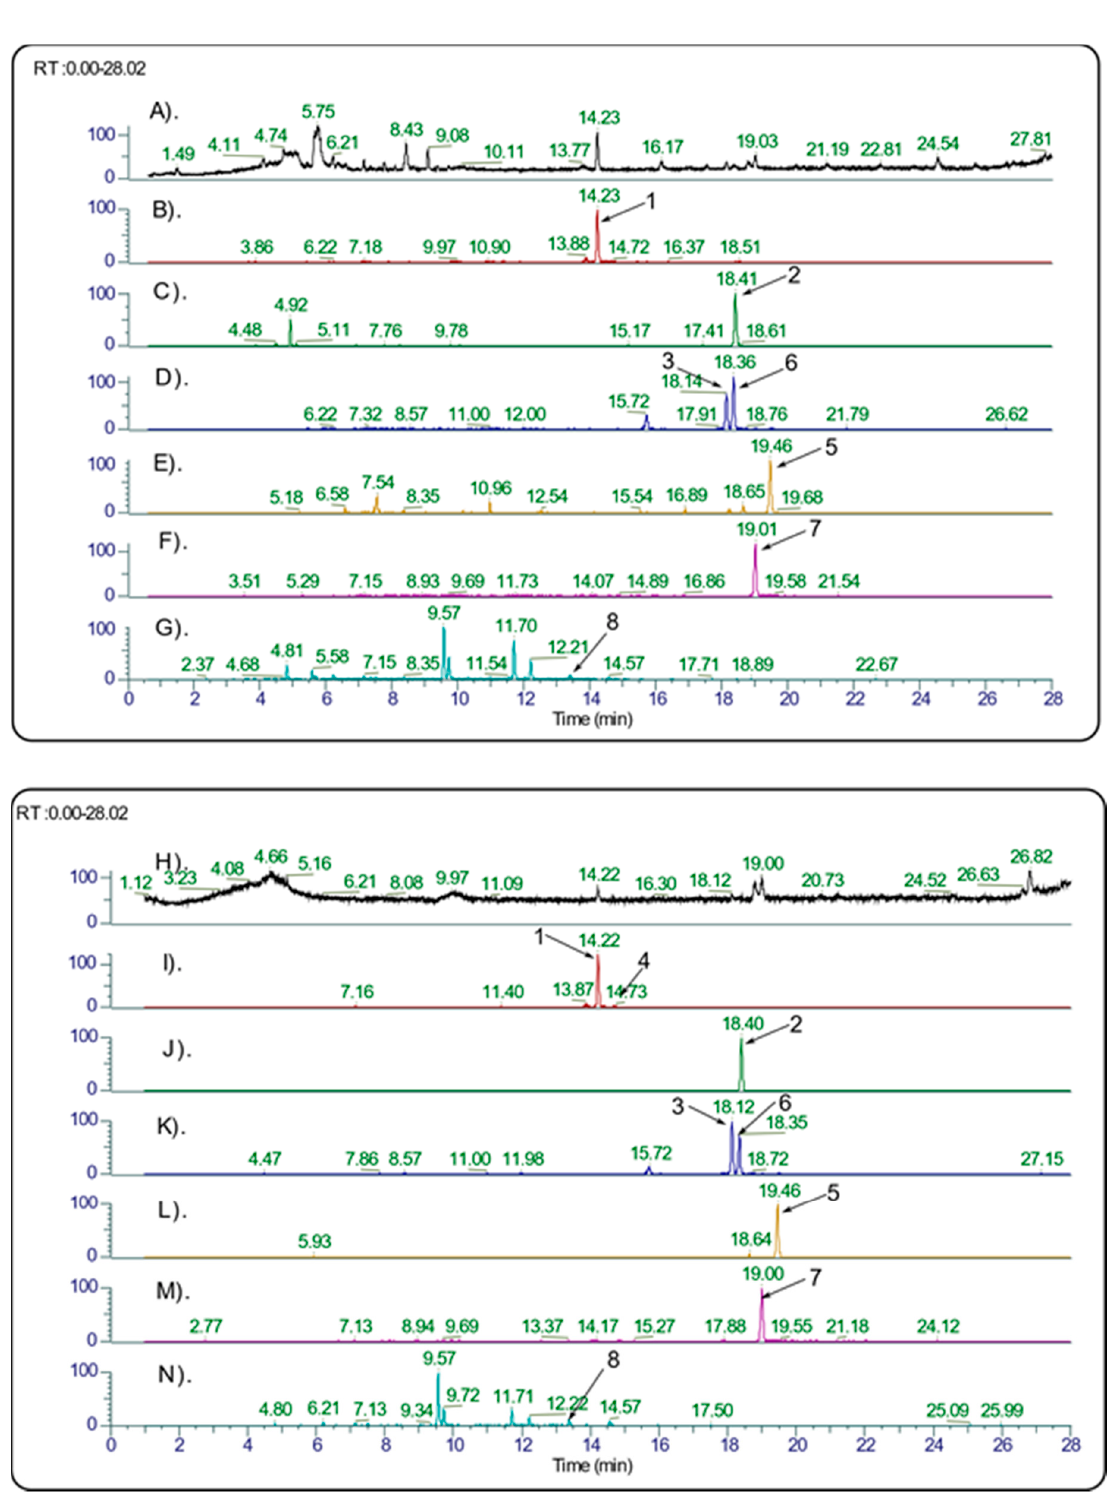
Figure 2. Example UHPLC chromatograms of cytotoxic juniper leaf extracts. The lignan numbers, shown on the chro- matograms with arrows, correspond to Figure 1. ( A ) Total Ion Chromatogram (TIC) of Grey Owl juniper extract (extract № 7, Table 1); ( B – G ) Extracted Ion Chromatograms (XIC) of Grey Owl juniper extract at m / z 415.1387, 457.1496, 399.1438, 429.1544, 401.1595, and 359.1489, respectively, with a 5 ppm isolation window; ( H ). TIC chromatogram of J. virginiana L. extract (extract № 1, Table 1); ( I – N ) XIC chromatograms of J. virginiana L. extract at m / z 415.1387, 457.1496, 399.1438, 429.1544, 401.1595, and 359.1489, respectively, with a 5 ppm isolation